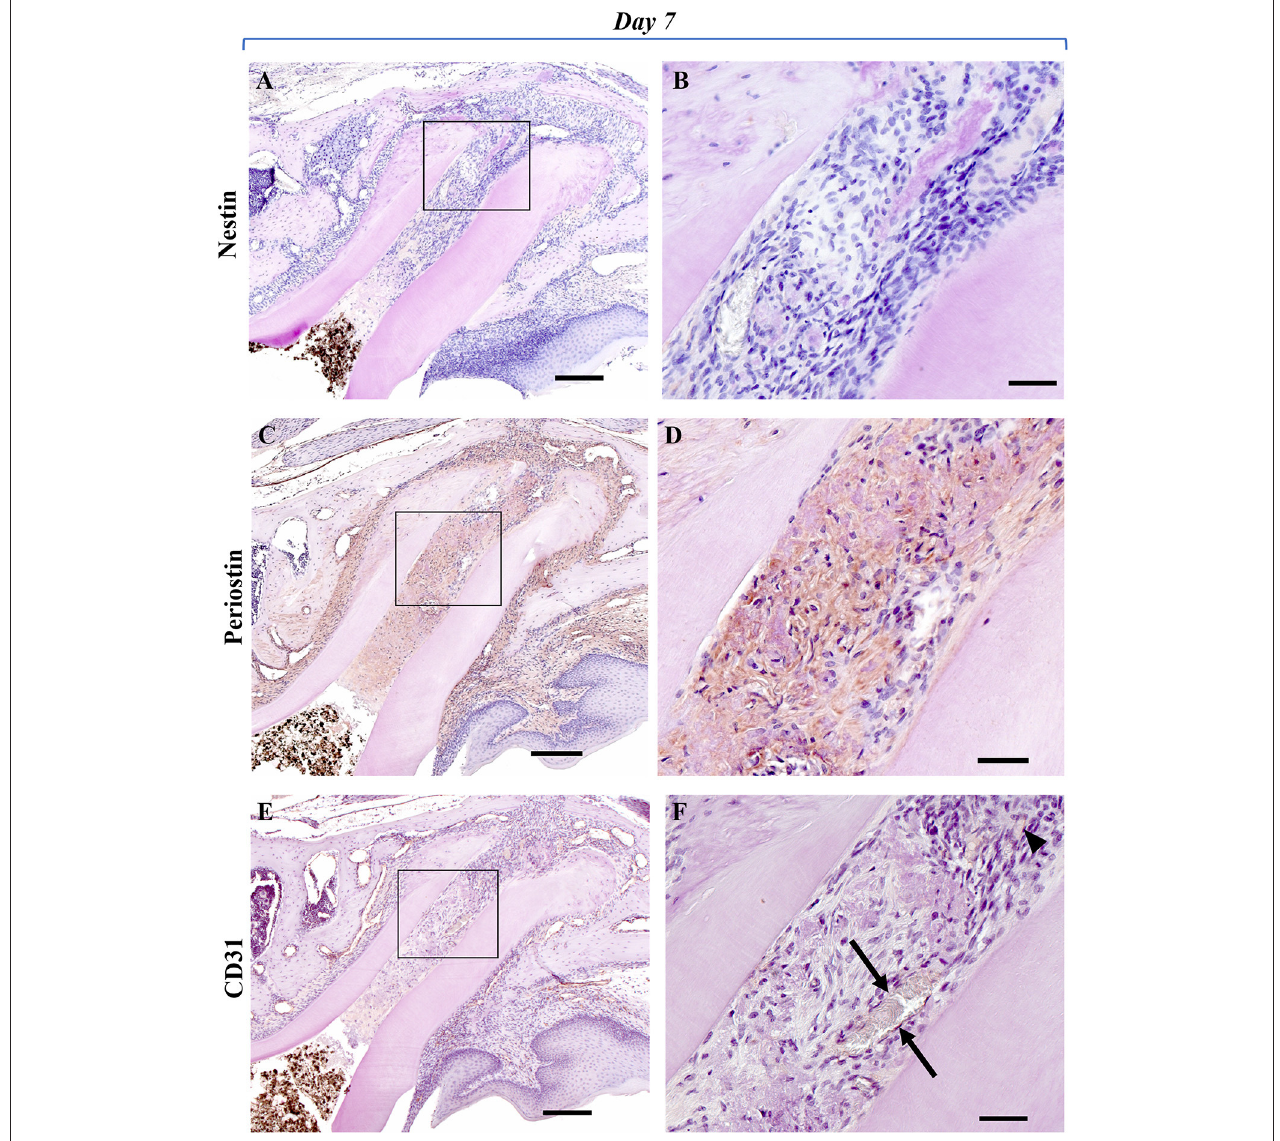
FIGURE 3 | Representative IHC-stained images of the experimental group at 7 days. Nestin: (A,B) ; Periostin: (C,D) ; CD31: (E,F) . (A) No nestin-positive cells were observed in the mesial root canal or around the apex. (B) Higher magnification of the black box area in (A) . No cells showing a nestin-positive reaction were observed in the immature granulation tissue that filled the root canal. (C) Periostin-positive cells were markedly observed in the mesial root canal and in the surrounding PDL region. (D) Higher magnification of the black box area in (C) . A marked periostin-positive reaction was observed in the periapical fibrotic connective tissue and in the immature granulation tissue that filled the root canal. (E) CD31-positive reaction was observed in the immature granulation tissue of the mesial root canal. (F) Higher magnification of the black box area in (E) . In the center area of the root canal, spindle-shaped vascular endothelial cells (arrowhead) and new blood vessels with a luminal structure (black arrow) were observed that were positive for CD31 (Scale bars = 200 µ m in A, C, E; scale bars = 50 µ m in B, D,